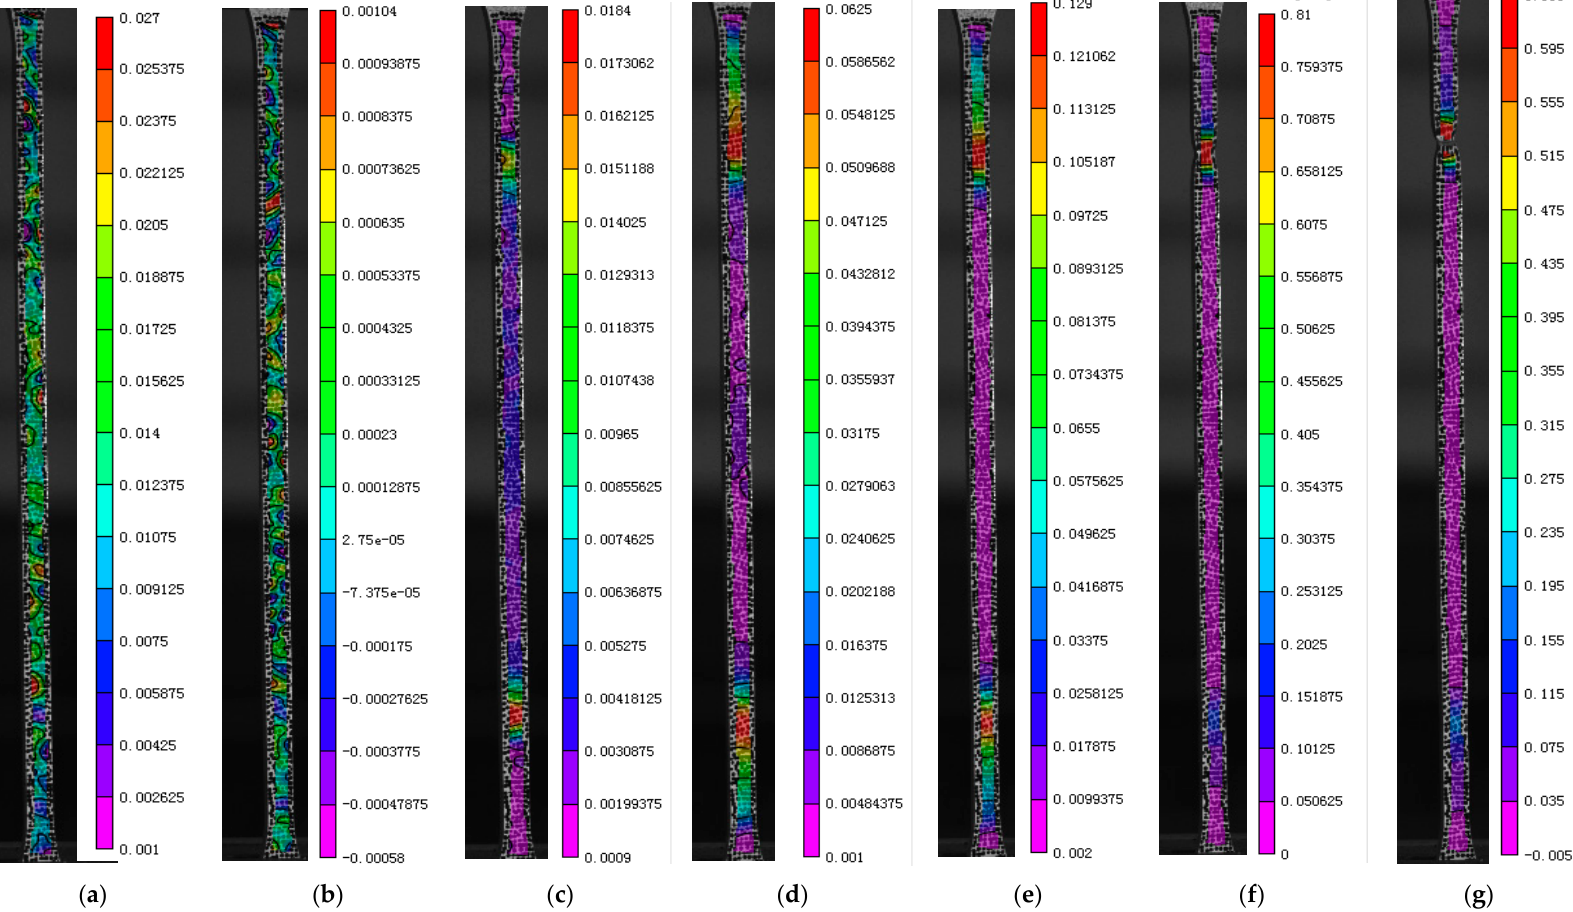
Figure 9. Cloud map of full-field equivalent strain change with time in tensile test: ( a ) Step 40; ( b ) Step 60; ( c ) Step 90; ( d ) Step 120; ( e ) Step 150; ( f ) Step 190; ( g ) Step 192.